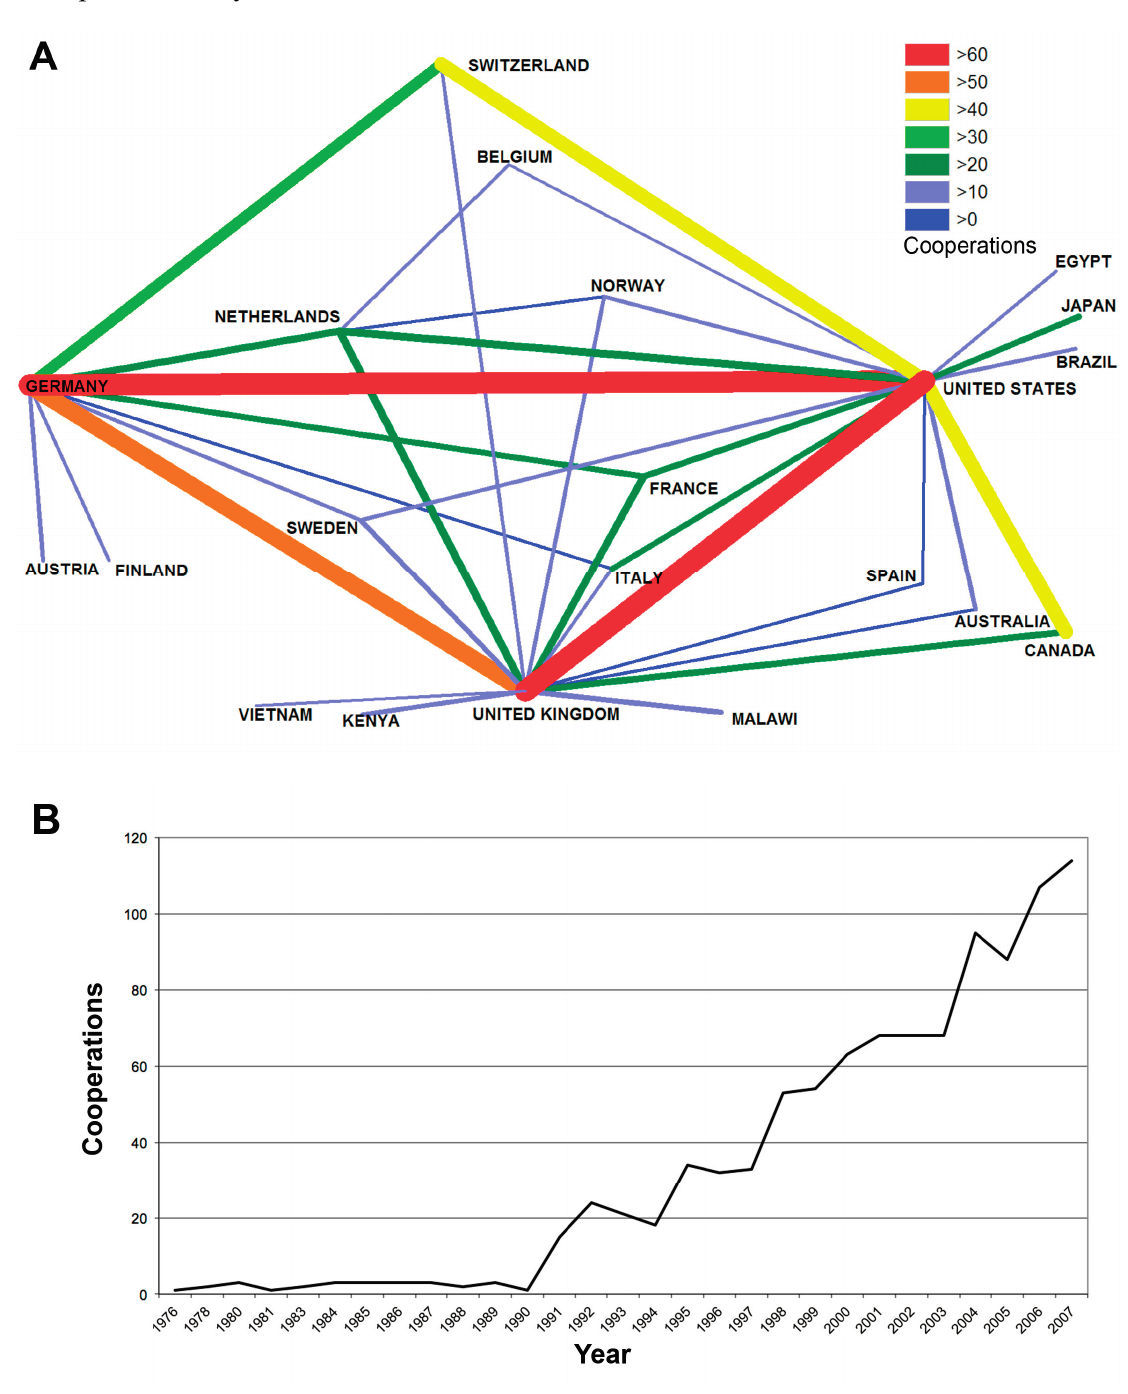
Figure 3. Cooperation. ( A ) Spider chart of international cooperation. Line thickness and color indicate the amount of cooperation between countries. Colors and line thickness indicate the numbers of bilateral cooperation. ( B ) Development of cooperation over a time period of 31